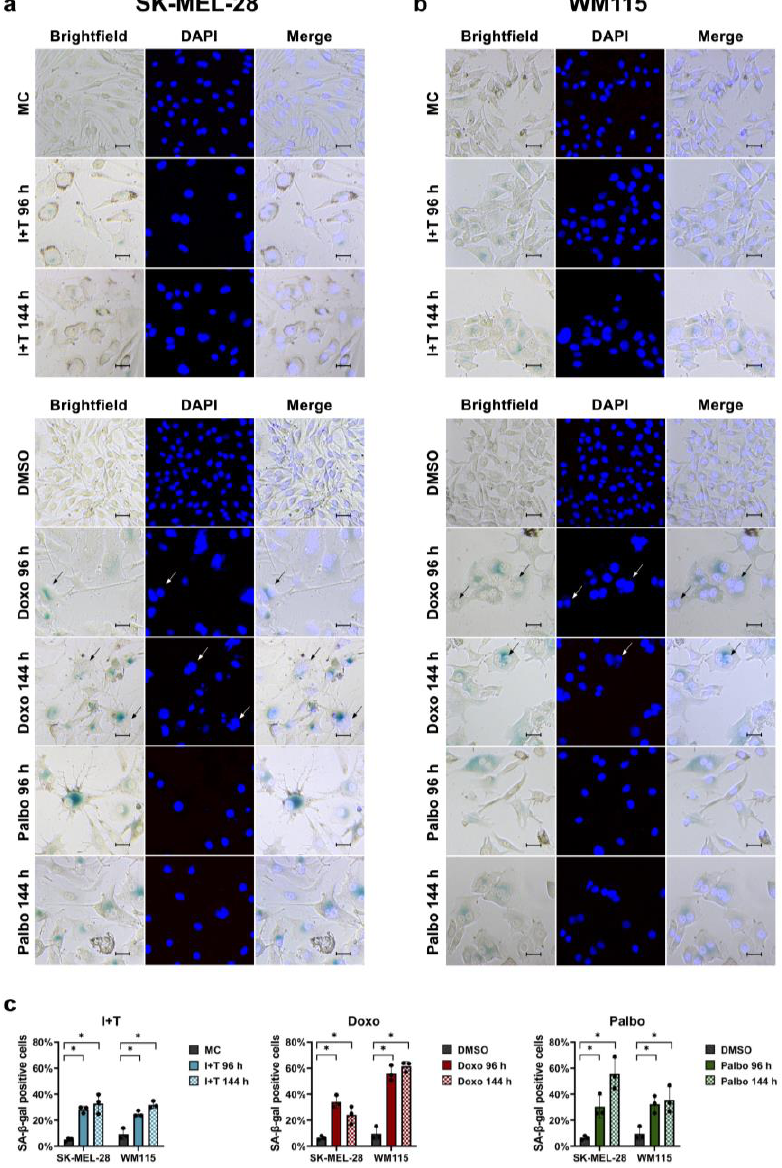
Figure 1. Induction of SA- β -gal activity after treatment with IFN- γ and TNF (I+T), doxorubicin (Doxo), and palbociclib (Palbo). ( a , b ) Representative images of SA- β -gal and DAPI staining in SK-